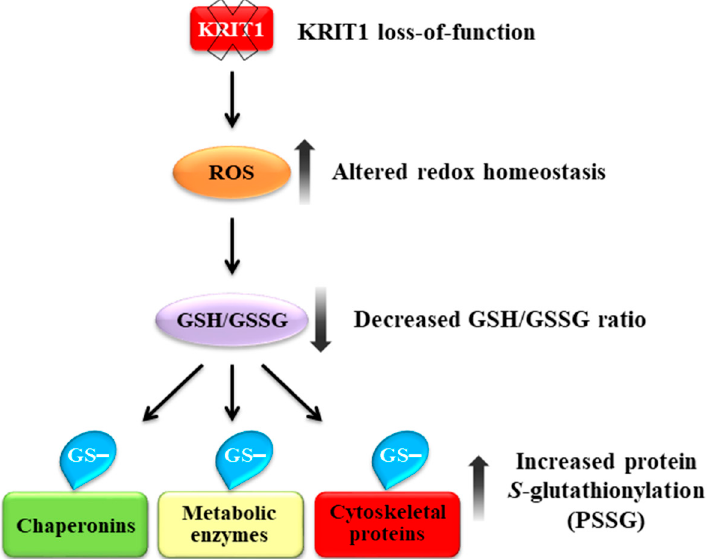
Figure 9. Schematic model representing the S -glutathionylation of distinct structural and regulatory proteins as a novel molecular signature of KRIT1 loss-of-function. The altered intracellular redox homeostasis caused by KRIT1 loss-of-function affects the glutathione (GSH) redox system, leading to a significant decrease in total GSH levels and increase in oxidized glutathione disulfide (GSSG), with a consequent deficit in the GSH/GSSG redox ratio and GSH-mediated antioxidant capacity. These effects are associated with increased S -glutathionylation of distinct proteins involved in adaptive responses to oxidative stress, including redox-sensitive chaperonins, metabolic enzymes, and cytoskeletal proteins, suggesting a novel molecular signature of KRIT1 loss-of-function that could contribute to its emerging pleiotropic effects in the pathogenesis of CCM disease.